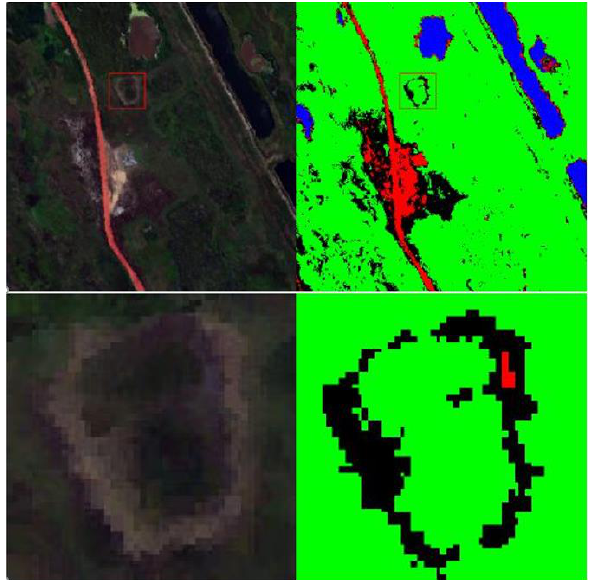
Figure 3 True colour image (left) and classification results (right). Legend: red: bare soil/man-made structure, blue: water, green: healthy vegetation, black: stressed vegetation.